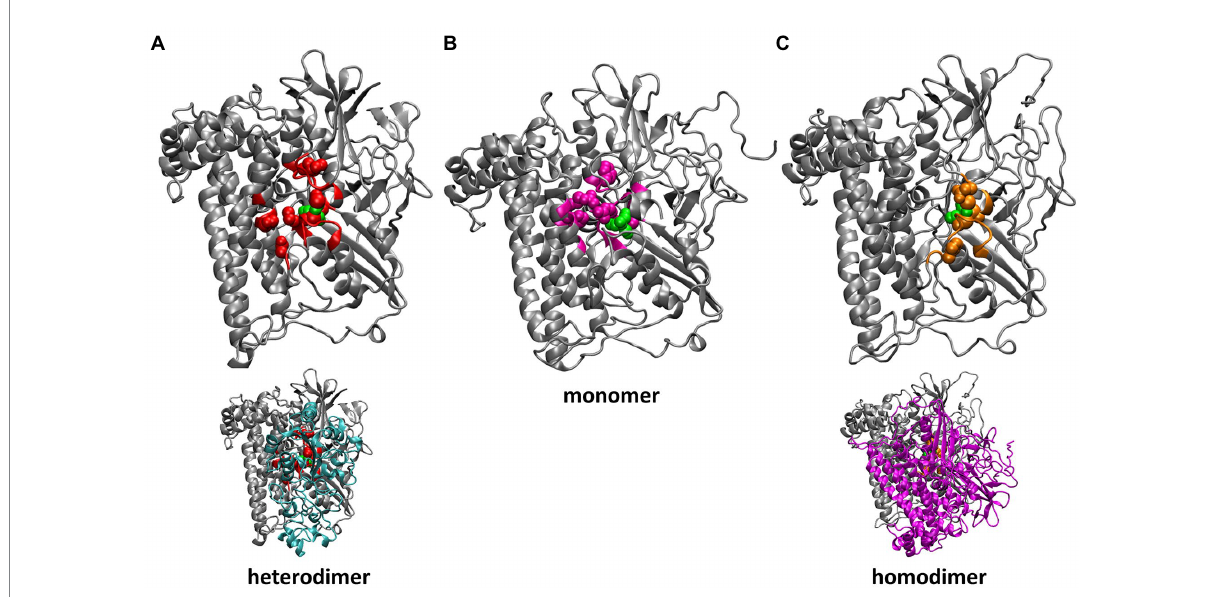
FIGURE 2 Residues of HoxG with highest rigidity constants (100 kcal·mol − 1 ·Å − 2 ): in the crystal structure of Cn MBH, HoxG MBH ( A , red), in a HoxG m structure taken from GaMD simulation 2 at 200 ns ( B , magenta) and in one monomer of the HoxG d structure taken from GaMD simulation at 150 ns ( C , gold). The structures of the entire Cn MBH heterodimer and the entire HoxG d are also displayed ( A , C , bottom). The [NiFe] active site is shown in green. The protein backbone of residues with force constants less than 100 kcal·mol − 1 ·Å − 2 is shown in